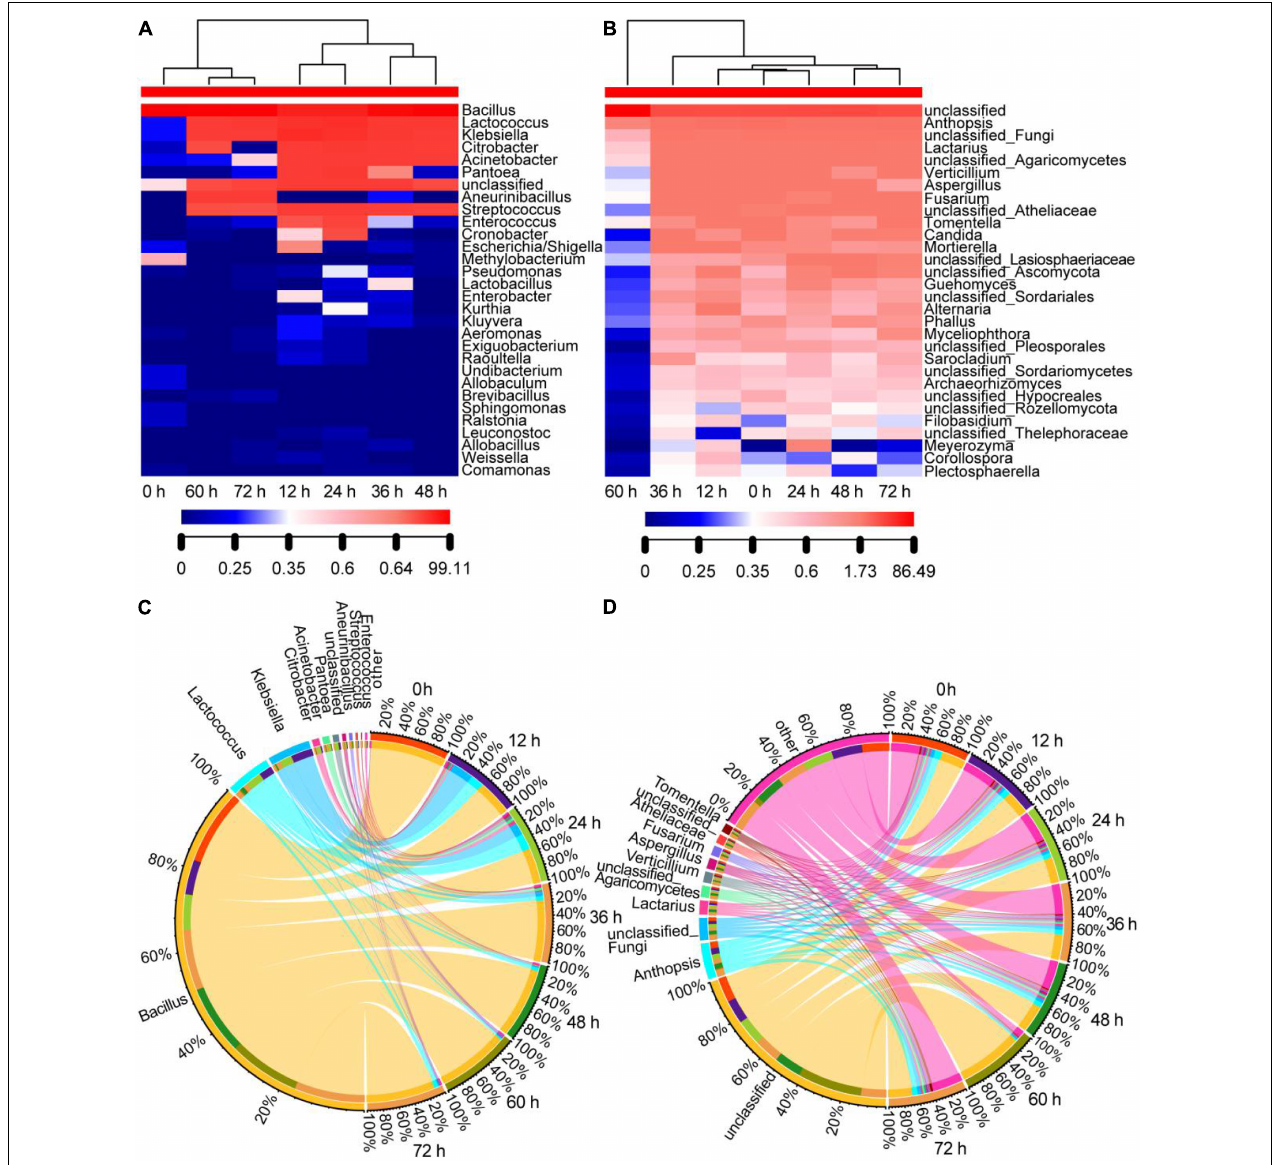
FIGURE 3 | Genera distribution of the bacterial and fungal communities in the non-post fermented Shuidouchi: (A) Bacterial community heatmap (top 30 genera); (B) fungal community heatmap (top 30 genera), where the number indicates the value of the genus relative abundance; (C) the Circos of the bacterial genera distribution in the samples; (D) the Circos of the fungal genera distribution in the samples, where the relative abundance of the genera is represented by the relative tick on the outer circle, and the relative abundance of the genera is represented by the thickness of the colorful